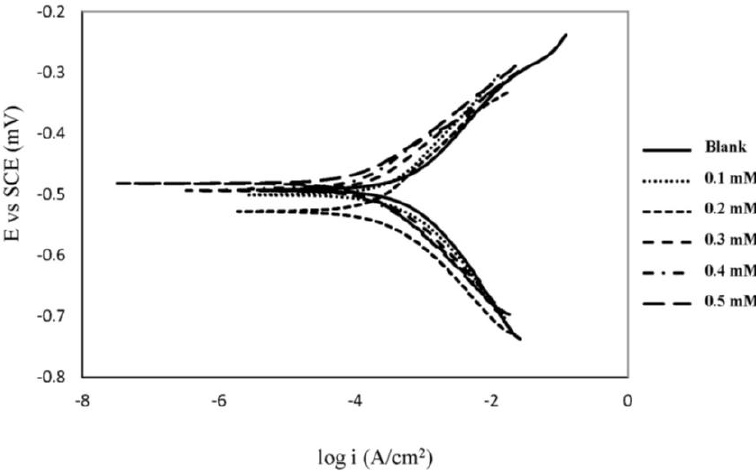
Figure 2. Potentiodynamic polarization curves for mild steel in 1.0 M HCl at 30 °C with different concentrations of chlorocurcumin.